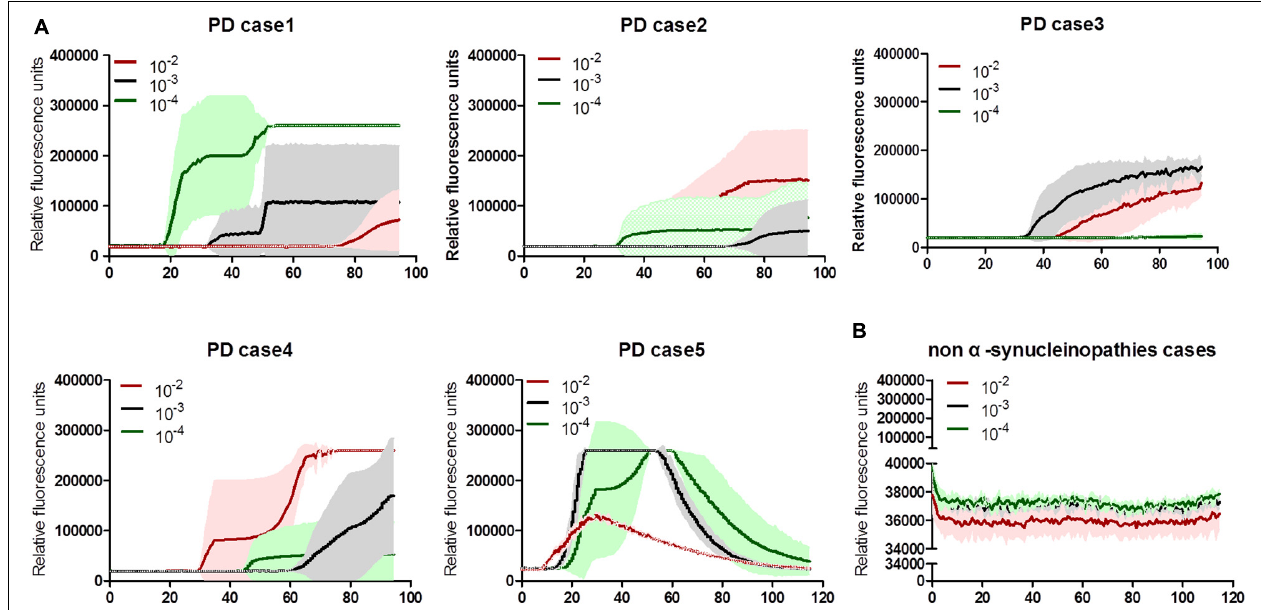
FIGURE 1 | α -Syn RT-QuIC spectra of serially diluted brain homogenates of neuropathological confirmed PD and non- α -synucleinopathy cases. (A) Individual 5 cases of PD. (B) Summarized spectra non- α -synucleinopathy cases, including a normal person, 8 cases of neuroglioma, 3 cases of FFI, and 1 G114V gCJD. The dilutions are indicated on the top. Y -axis represents rfu (ThT value). X -axis represents the time (h) post-reaction. Each reaction consists of 3–4 duplicates.